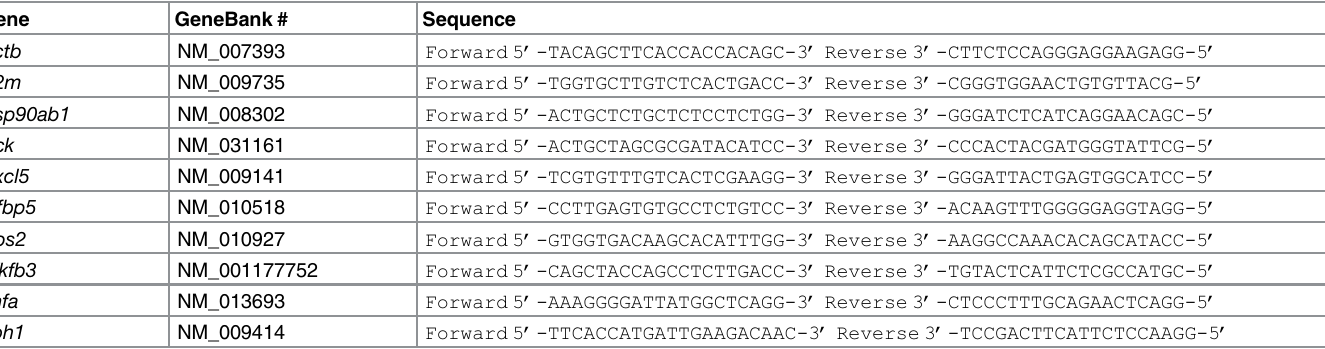
Table 2. Primer Sequences for Genes Quantified by Real-Time PCR a